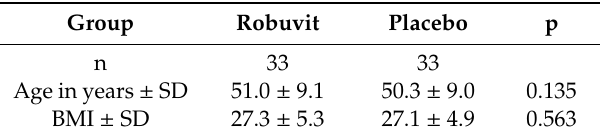
Table 1. Basic demographic data of